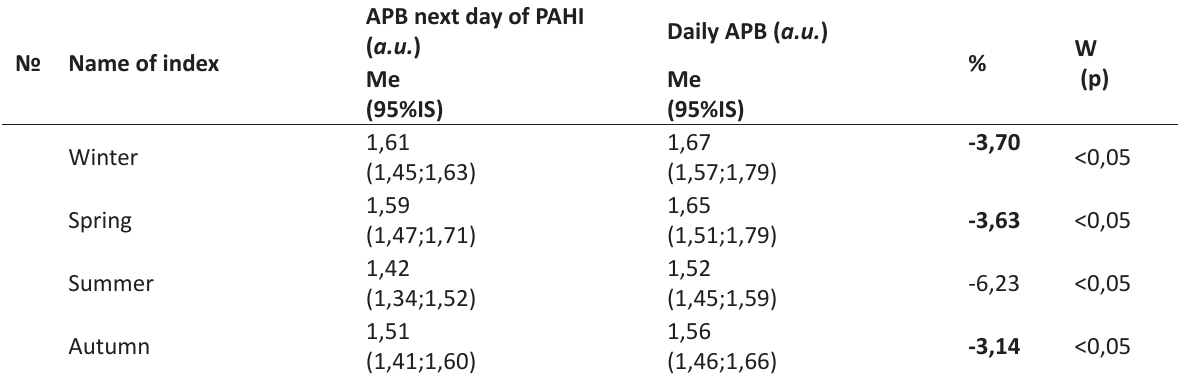
Table 5. Comparison of APB indices of the next day after PAHI with men’s daily indicators in seasonal periods